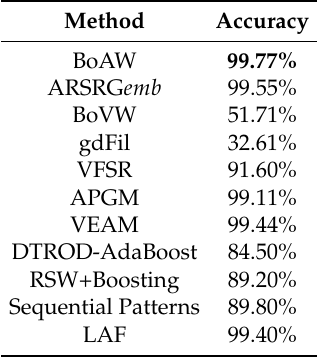
Table 12. Results on the COIL-100 dataset.